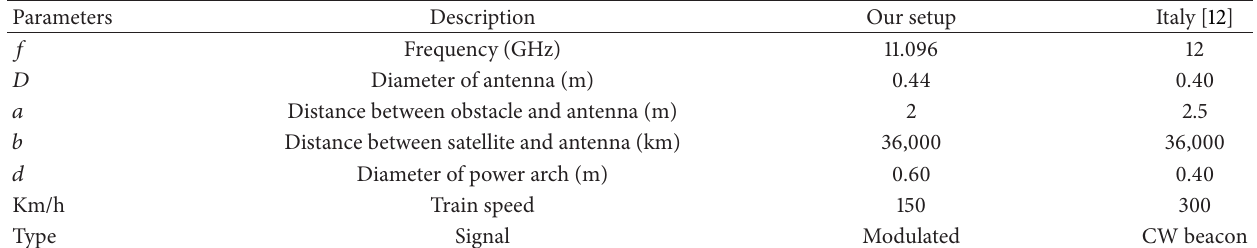
Table 1: Parameters used for the two scenarios in temperate and tropical